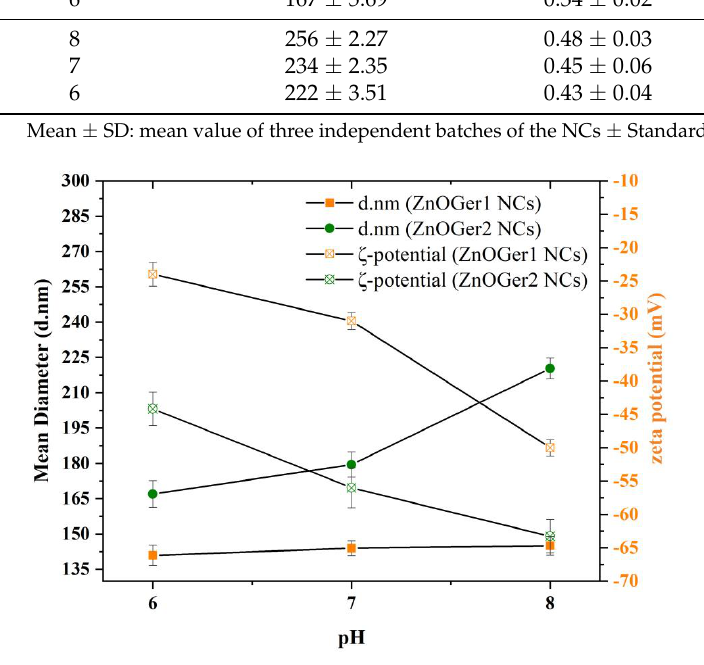
Figure 5. Physicochemical parameters and stability evaluation ZnOGer1 NCs and ZnOGer2 NCs containing commercial geraniol. The stability evaluation was performed for pH values 6, 7, and 8. Mean diameter (d.nm) by dynamic light scattering (DLS), ζ -potential (mV), and pH. All analyses were performed in triplicate (n = 3; Mean ± SD) at 25 °C.